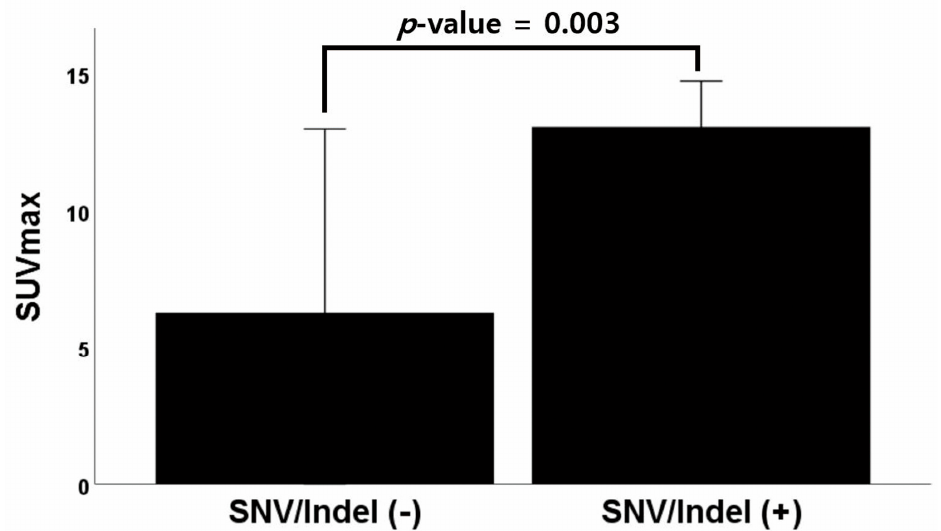
Figure 1. Graph of the difference in average SUVmax between patients with and without SNV/Indel variants. Abbreviations: SUVmax, maximum standardized uptake value; SNV, single nucleotide variants; Indel, insertions and deletions.